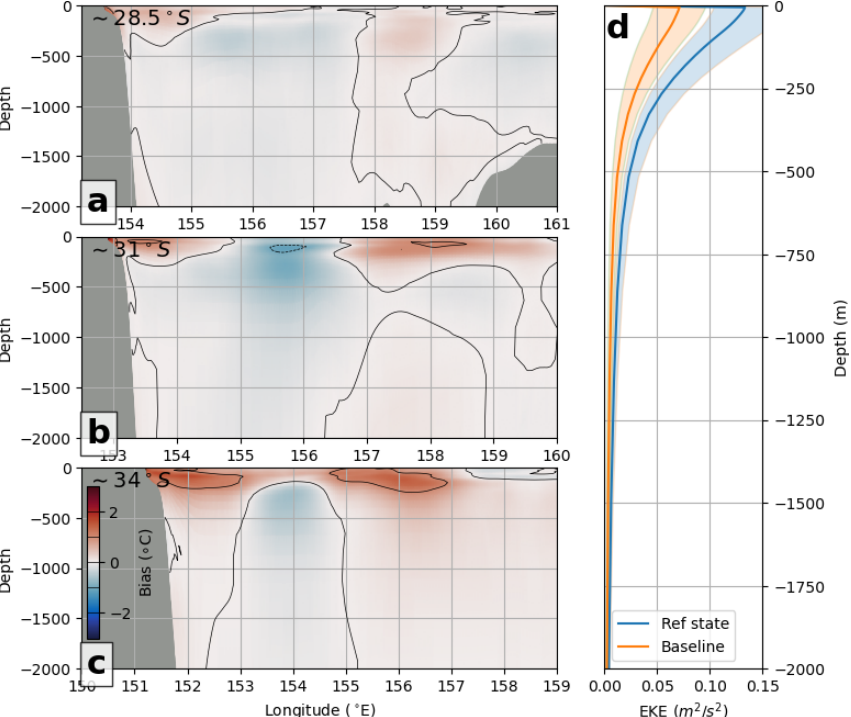
Figure A1. The temperature bias between the baseline and the Ref state is shown at three transects, (a) ∼ 28.5 ◦ S, (b) ∼ 31 ◦ S, and (c) ∼ 34 ◦ S. In (d) , the depth profile of EKE, averaged over the high-EKE box (see box in Fig. 3a), for the Ref state and baseline experiments.